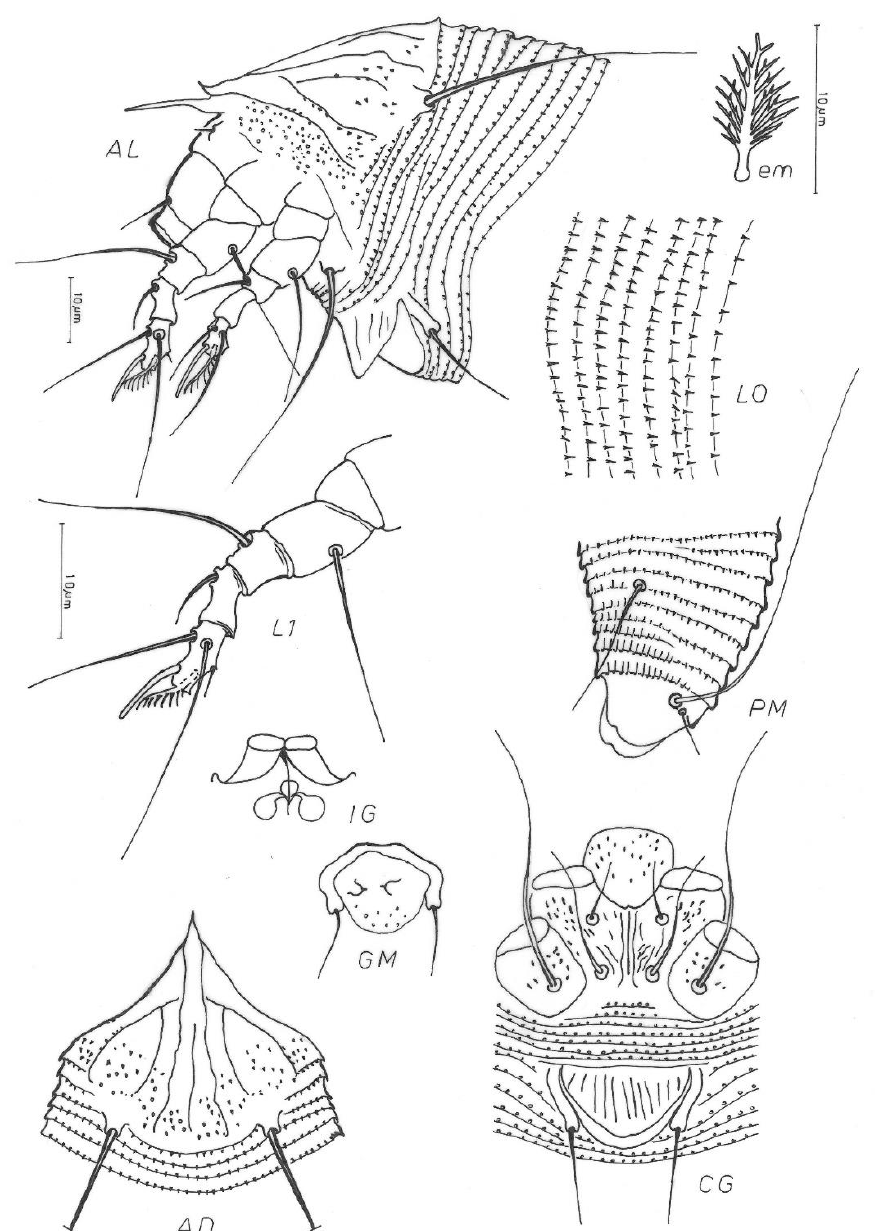
Figure 3. Schematic drawings of female Aculodes marcelli sp. nov. : AD=Prodorsal shield; AL=Lateral view of anterior body region; CG=Female coxigenital region; em=Empodium; GM=Male genital region; IG=Internal female genitalia; LO=Lateral view of annuli; L1=Leg I; PM=Lateral view of posterior opisthosoma.